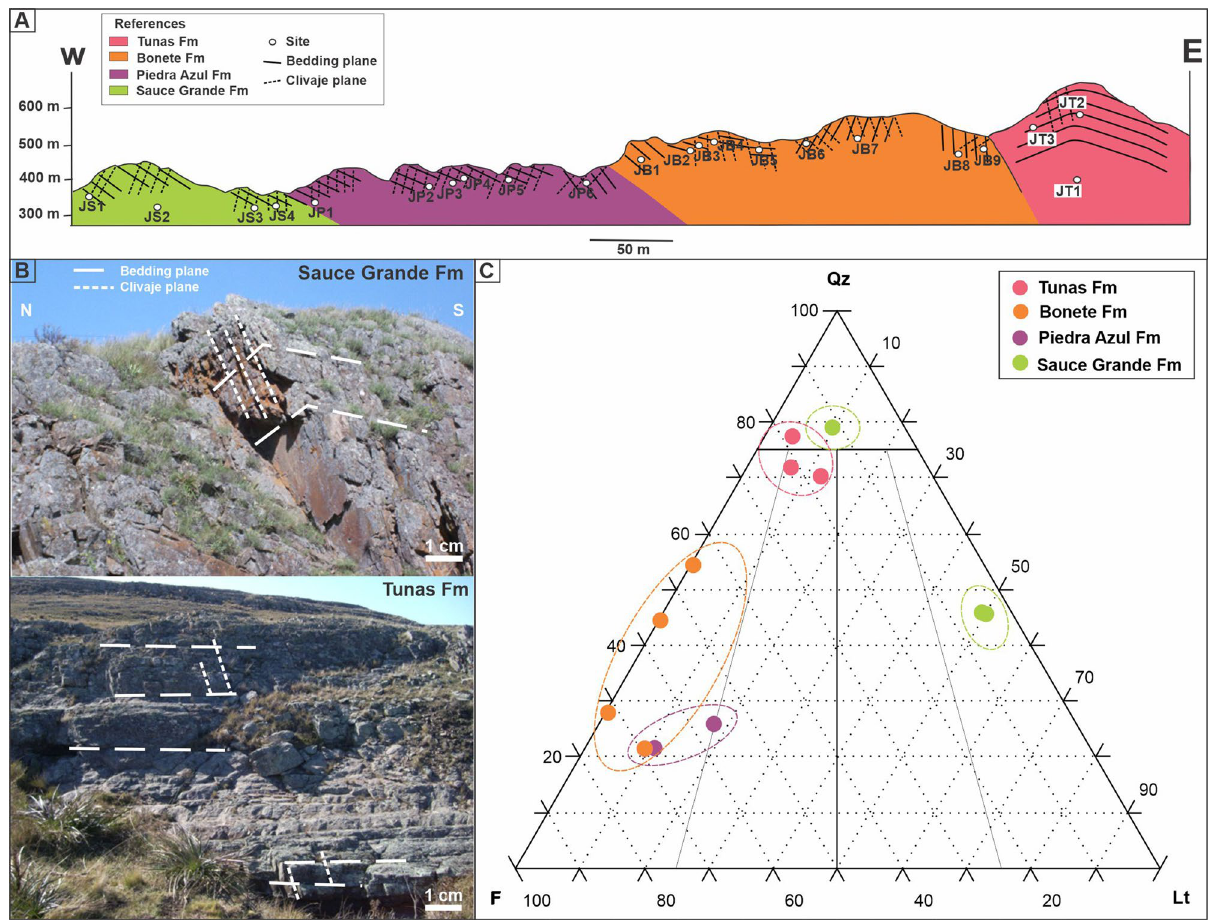
Figure 2. ( A ) Schematic reconstruction of the Arroyo Atravesado section (see Fig. 1), with the different formations of the Pillahuincó Group, its bedding and foliation. JS Sauce Grande sites, JP Piedra Azul sites, JB Bonete sites, JT Tunas sites. ( B ) Photographs show the differences of the folding at the base (Sauce Grande Fm, outcrop from the Road 76, near Ruta 76 locality) and at the top (Tunas Fm, outcrop from Golpe de Agua locality). ( C ) Petrographic plot of the analysed samples. Qz quartz, F feldspar, Lt total lithic